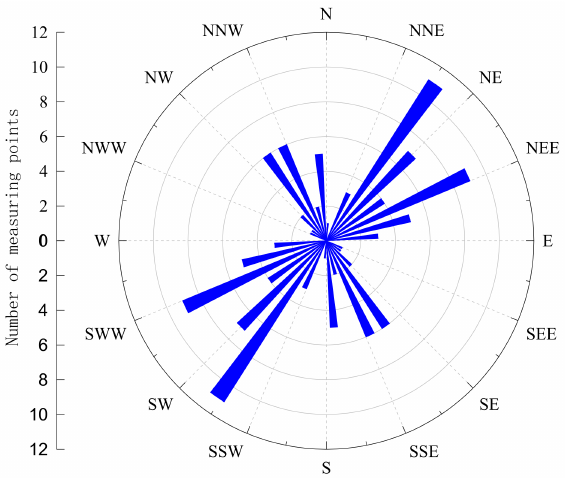
Figure 8. Rose diagram of the maximum principal stress in the mining